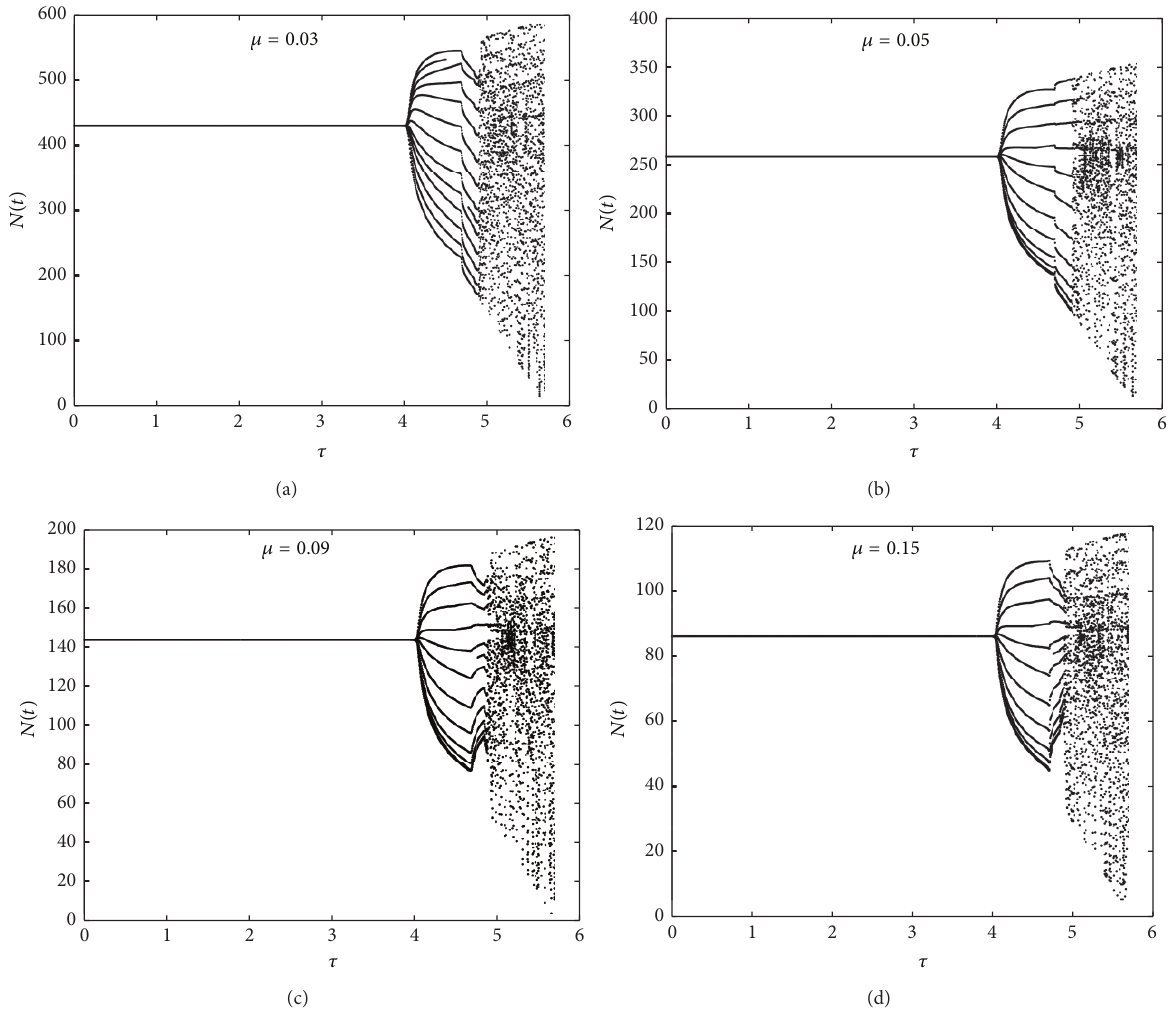
Figure 4: Bifurcation and chaotic properties of the dynamical system of credit risk contagion in the financial market when the time-delay 𝜏 is varied under the influence of the nonlinear resistance coefficient 𝜇